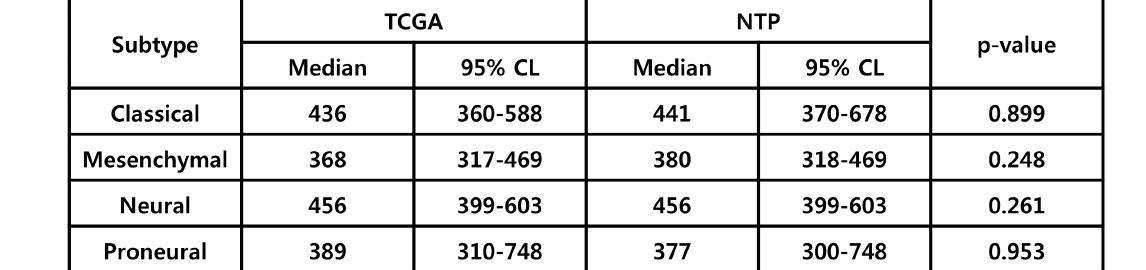
Figure 2. Clinical prognosis of 4 GBM molecular subtypes. 173 TCGA core GBMs’ molecular subtypes were determined by TCGA group ( A ) or the NTP method ( B ). ( A–B ) Kaplan Meier curves display overall survivals of the subtypes. ( C ) Median overall survival lengths (Median) and 95% confidence limits (CL) of the subtypes determined by either TCGA group or the NTP method were compared. Log rank test was used for statistical